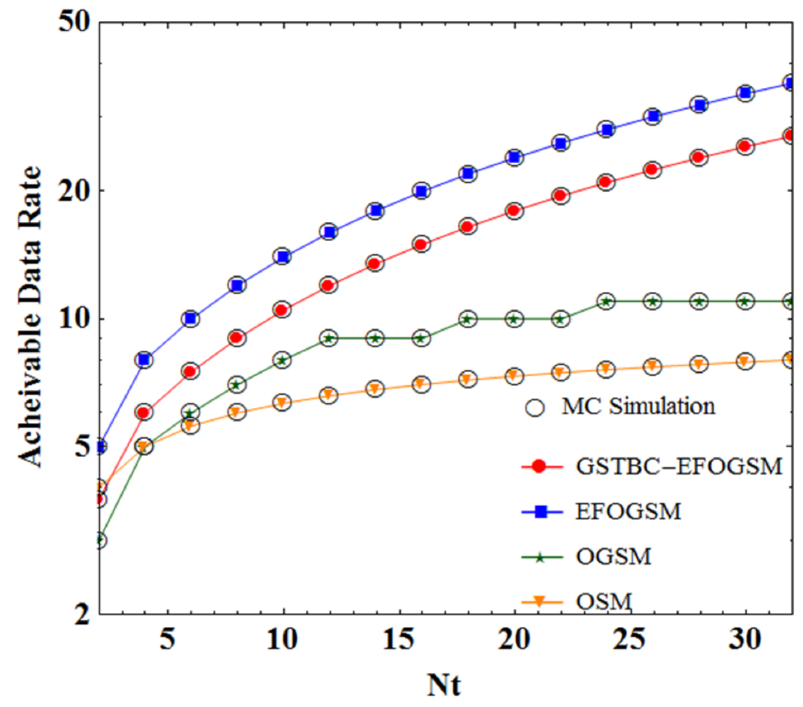
Figure 3. Data transmission rate R ‘